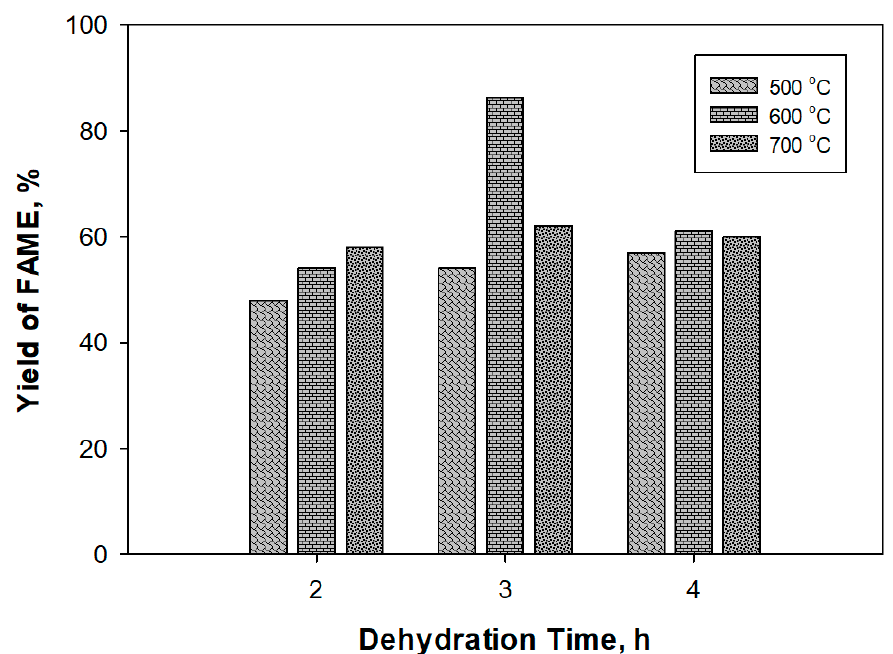
Figure 6. The influence of the dehydration temperature and time taken by the CaO / PMFA-900 / 3 h catalyst on its biodiesel yield.